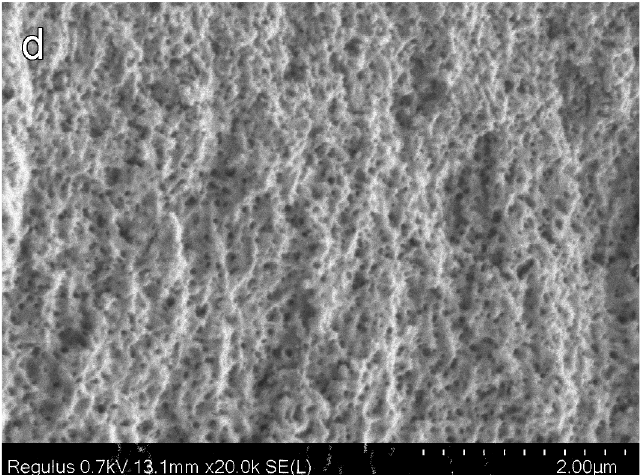
Figure 4. SEM micrographs cleavage surfaces of porous poly-OCM-2 monoliths prepared with various 1-butanol concentrations: ( a ) 0% (M1); ( b ) 12% (M3); ( c ) 16% (M5); ( d ) 18% (M6).